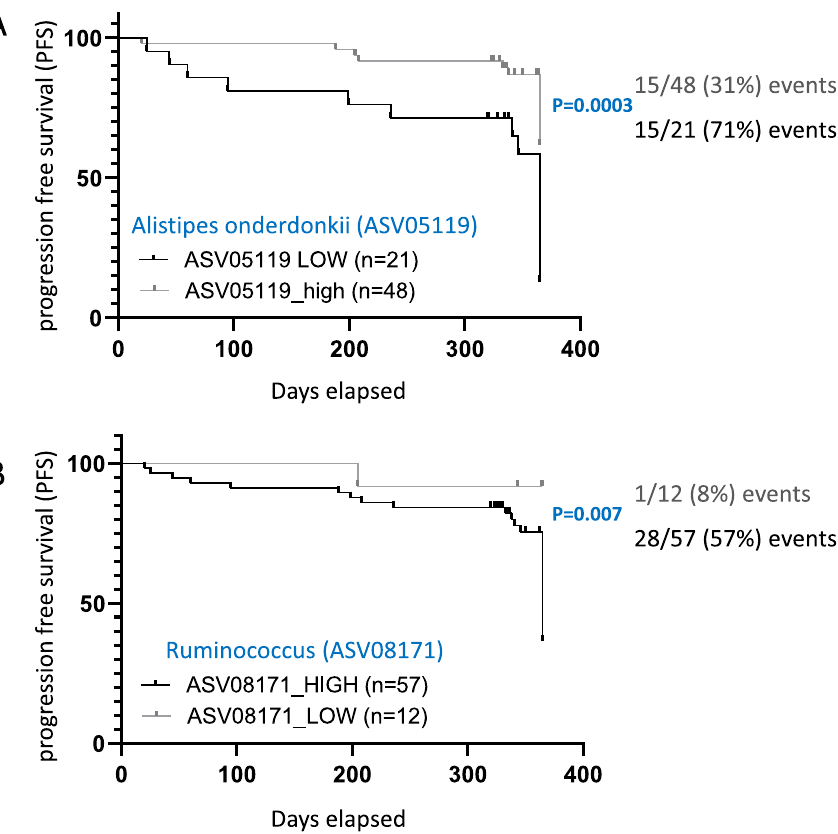
Figure 5. Higher Alistipes onderdonkii (ASV05119) and Ruminococcus (ASV08171) abundance is associated with durable clinical benefit (DCB). 69 patients with available data were included. ( A ) Regarding Alistipes onderdonkii (ASV05119) data, a Youden point of 0.00018 was calculated to discriminate between DCB+ and DCB− patients; based on that value 69 patients were stratified to low or high (above 0.00018) for a Kaplan– Meier DCB analysis [Log-rank (Mantel–Cox) test P value = 0.0003, and Hazard Ratio 3.08 (95% CI of ratio: 1.34–7.06)]. ( B ) Regarding Ruminococcus (ASV08171), a Youden point of 0.0004 was calculated to discriminate between DCB+ and DCB− patients; based on that value 69 patients were stratified to low or high (above 0.0004) for a Kaplan–Meier DCB analysis [Log-rank (Mantel–Cox) test P value = 0.007, and Hazard Ratio 7.76 (95% CI of ratio: